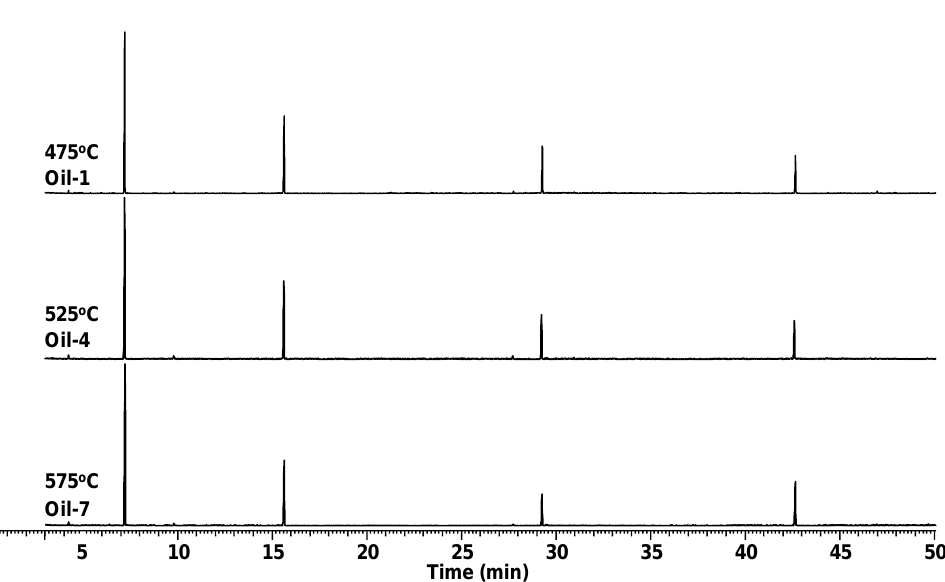
Figure 5. GC–MS chromatograms of PS pyrolysis oil-1, oil-4, and oil-5. Table 5. PS pyrolysis oil composition. The pyrolysis chars were analyzed by DSC and FTIR spectroscopy. DSC was used on